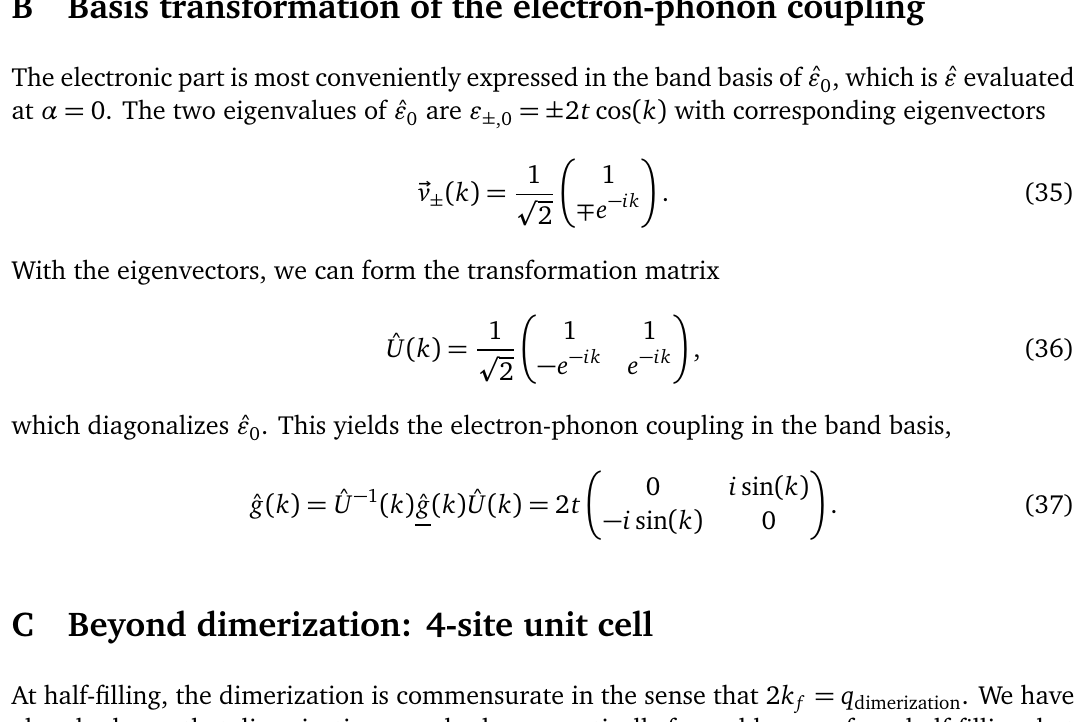
Figure 6: Length-4 unit cell with a periodic distortion (phonon eigenmode α arrows indicate the four hopping parameters t number and their position within the unit